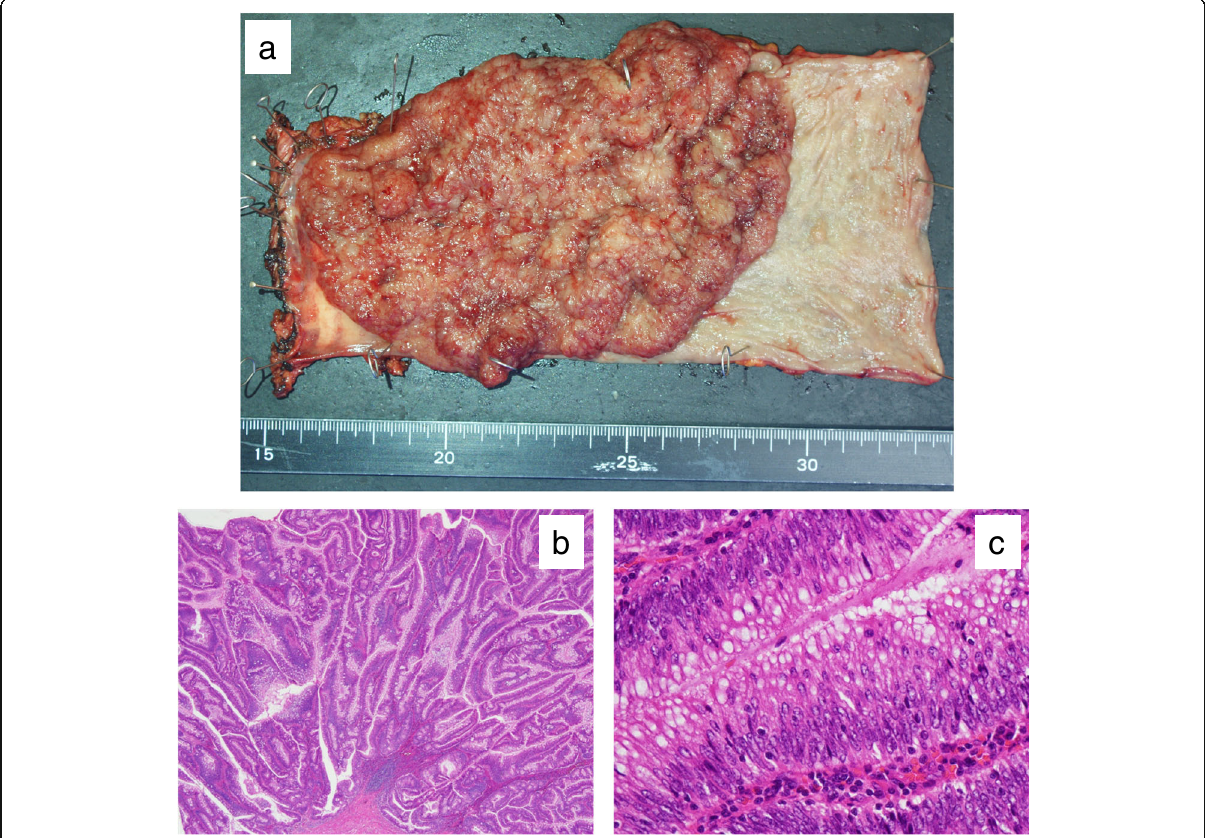
Fig. 5 Surgical specimen and microscopic findings. a A villous tumor at gross examination. b Hematoxylin – eosin stain (× 20) revealed papillary tumor. c Differentiated adenocarcinoma in tubulovillous adenoma was detected in some lesion (×